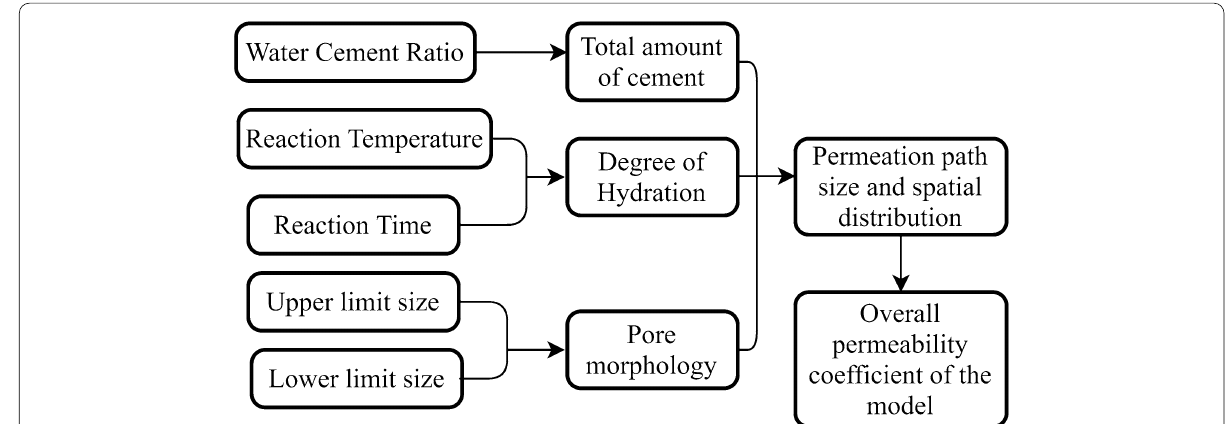
Fig. 11 Influence mechanism of the model permeability.